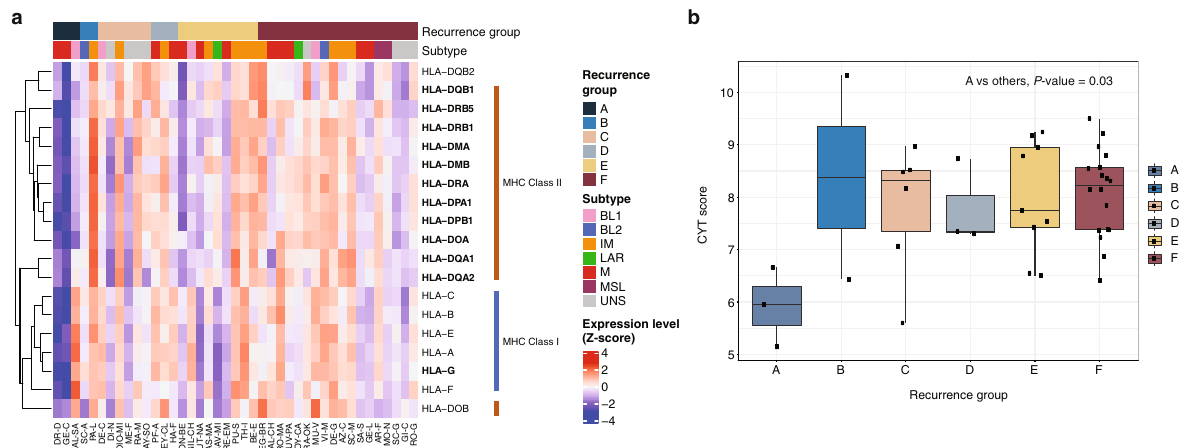
Fig. 3 Molecular characteristics of the intratumor immune response. a Heatmap of gene expression in the HLA family. Differentially expressed genes identi fi ed from A vs. F are marked in bold. Z-score of expression level was calculated for each gene across all 41 patients. Samples are presented with their original institutional identi fi ers. A – F, recurrence groups; BL1, basal-like 1; BL2, basal-like 2, IM, immunomodulatory; LAR, luminal androgen receptor; M, mesenchymal; MSL, mesenchymal stem-like; UNS, unclassi fi ed. Samples are presented by MSK-IMPACT assay identi fi ers (X-axis of the heatmap, identi fi ers of type tnbc-123-A or tnbc-123-AB). b Immune cytolytic activity (CYT). p -value between group A tumors and others was calculated using a two-tailed Student ’ s t -test.